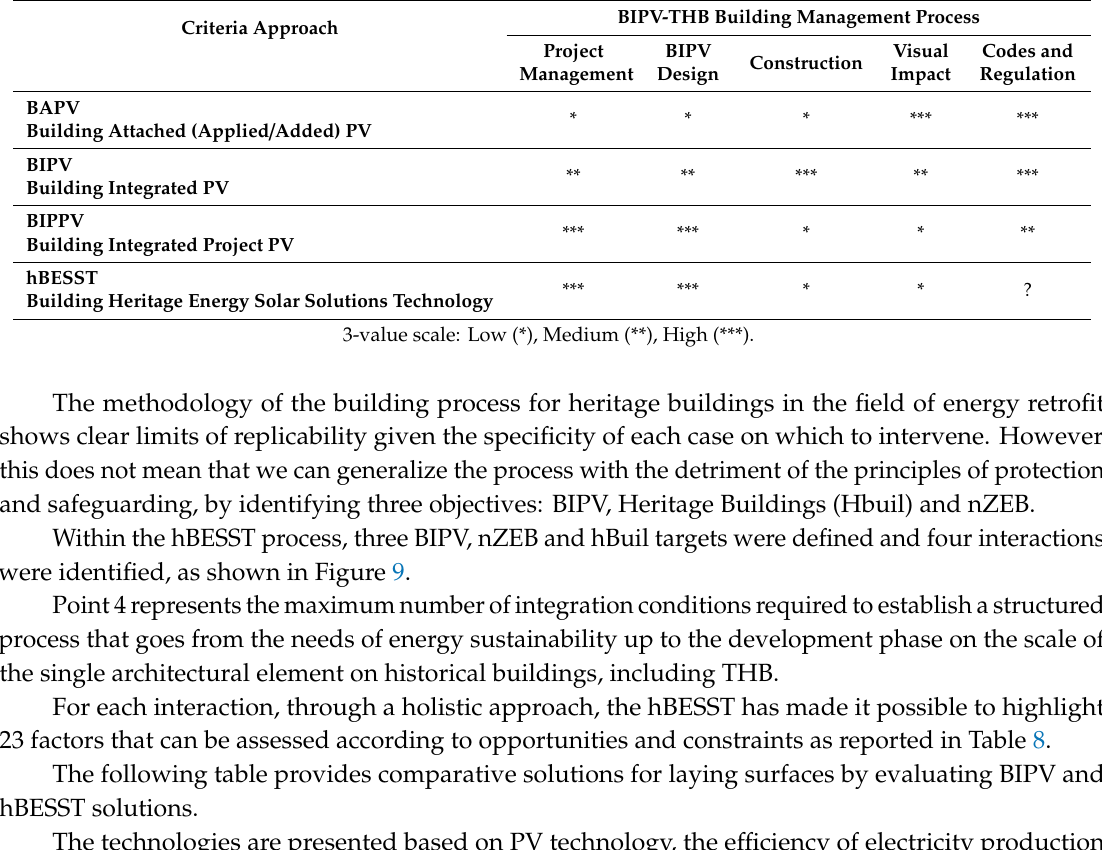
Figure 8. (Source: www.lofsolar.com) and Perovskite transparent PV cell. Table 7. Approaches and criteria within the Heritage Building Management Process for di ff erent BIPV